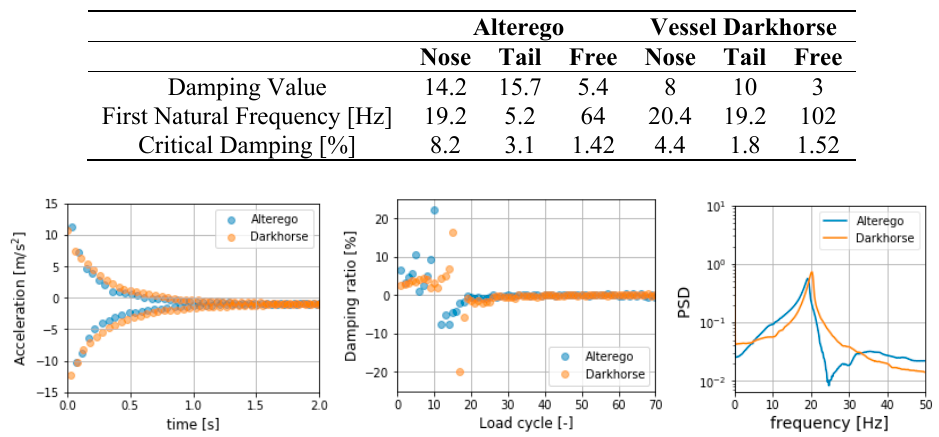
Table 3. Overall values from decay tests.